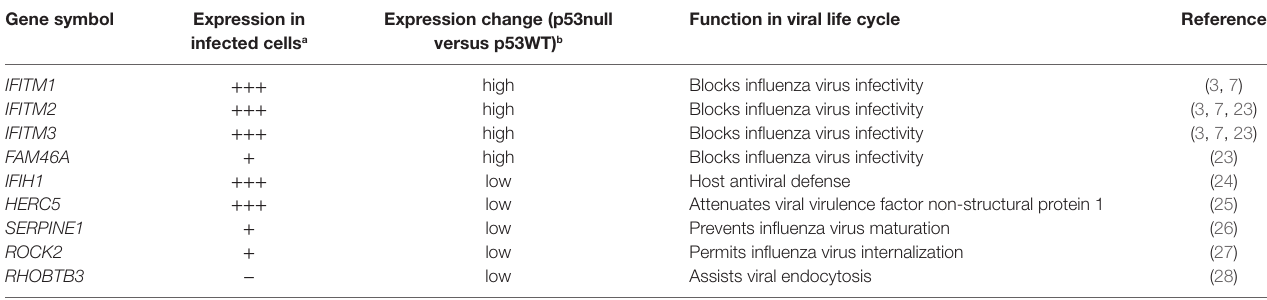
TaBle 1 | p53-regulated genes involved in influenza virus life